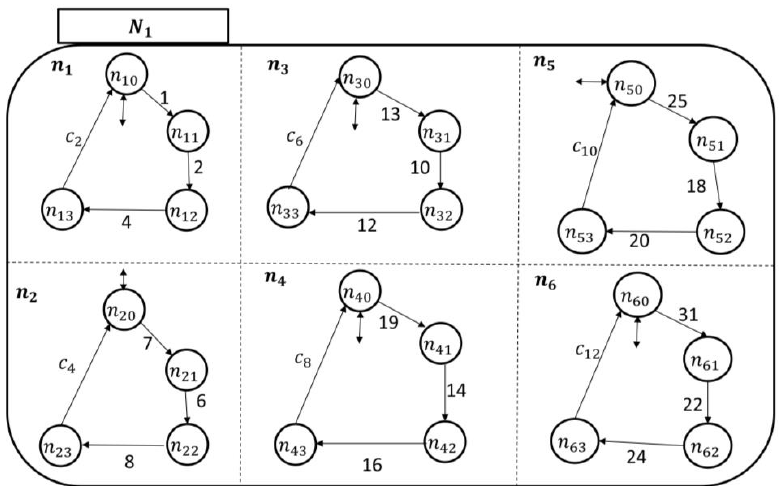
Figure 14. The nursing station automaton (𝑵 𝟏 ) transitional model.